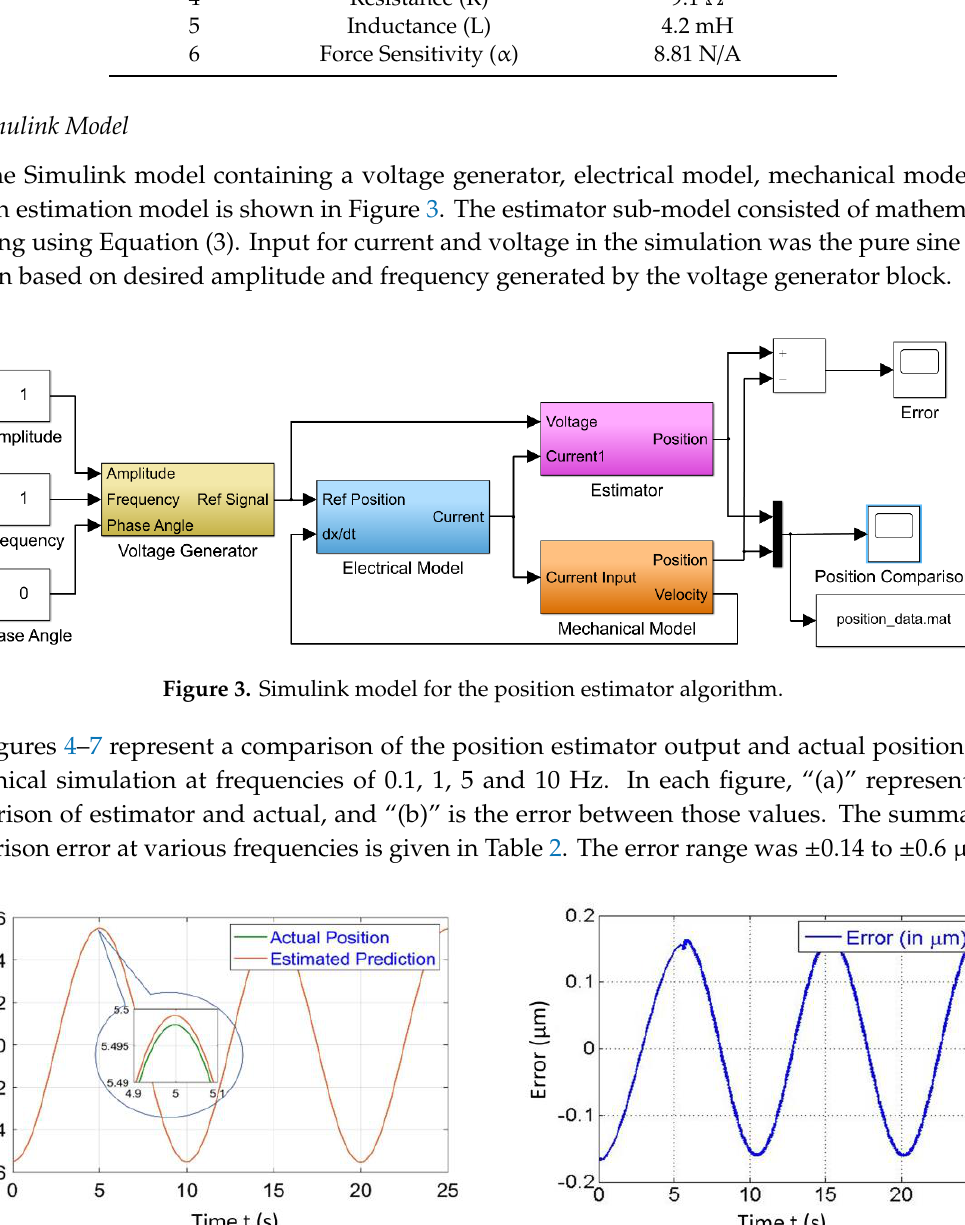
Figure 3. Simulink model for the position estimator algorithm.